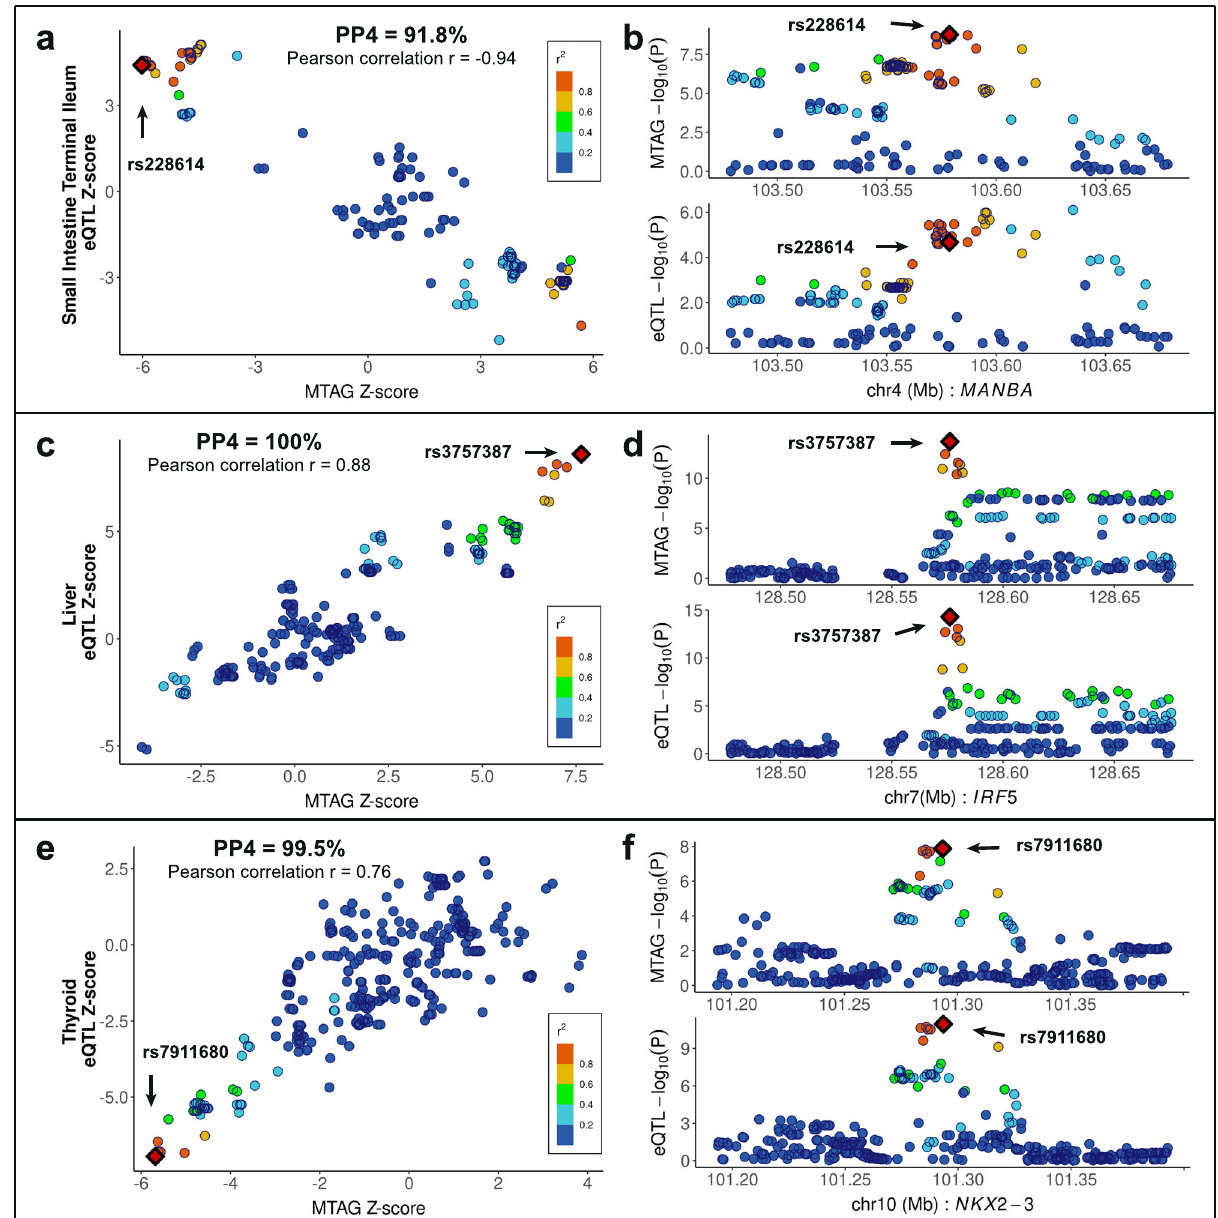
Fig. 4 | Functional validation of the MTAG-identi fi ed PSC-speci fi c candidate genes. a , c , e eQTL signals in GTEx v8 small intestine terminal ileum ( n =174) for MANBA ( a ),liver( n =208)for IRF5 ( c ),andthyroid( n =574)for NKX2-3 ( e )colocalize with those of the MTAG-identi fi ed PSC-speci fi c GWAS by coloc (posterior prob- ability for the same causal variant shared between MTAG-identi fi ed GWAS and a tissue-speci fi c eQTL (PP4)=0.918 for rs228614, PP4=1.00 for rs3757387, and